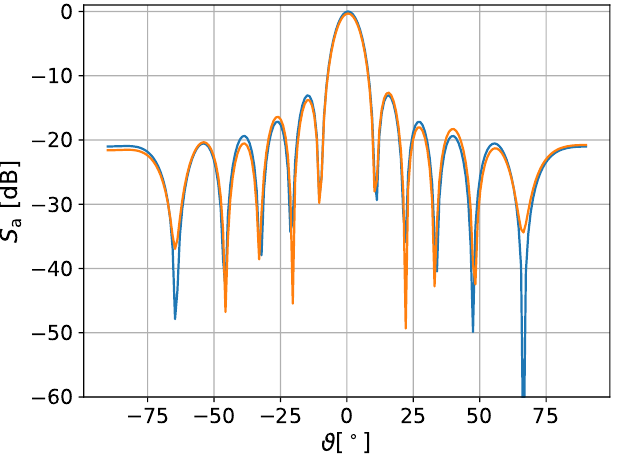
Figure 6. Comparison of Woodward–Lawson method (orange line) and optimization (blue